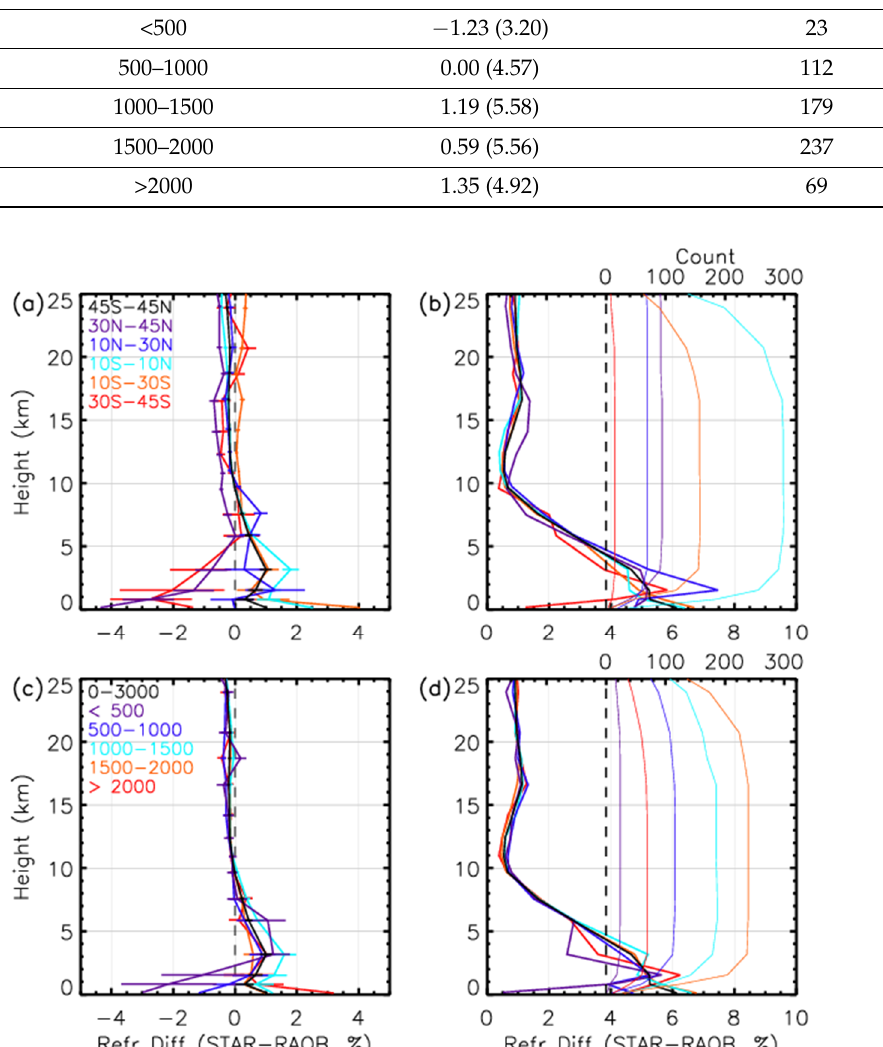
Figure 12. Fractional difference of STAR-RAOB (Vaisala RS92) refractivity for RO and radiosonde data collocated between Oct 01 – Oct 31, 2019; (a) mean, (b) standard deviation at different latitude bands, (c) mean, and (d) standard deviation at different SNR ranges. The count of collocated RO- ROAB pairs is shown by thin lines in (b) and (d).